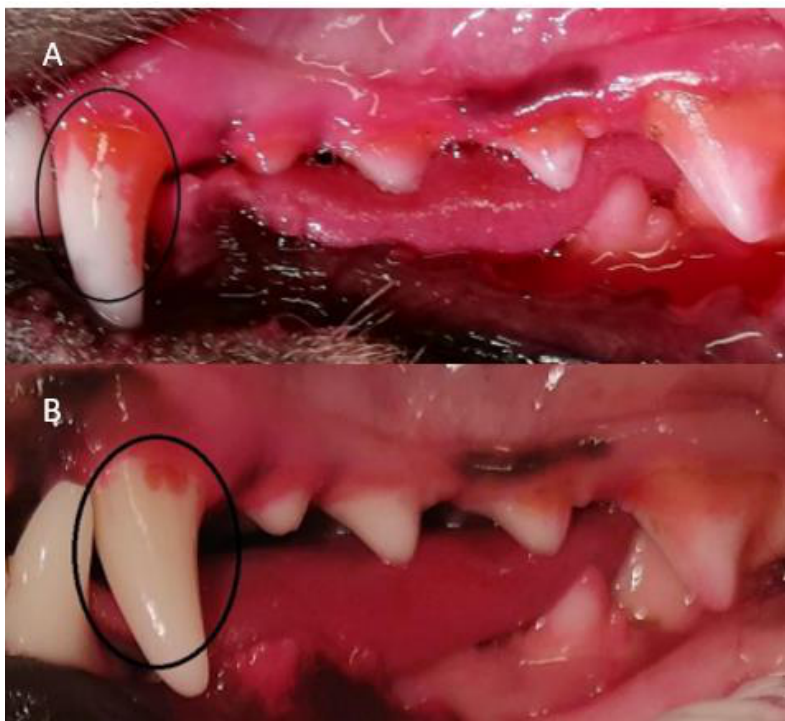
Figure 3. ( A ): Staining before treatment in dog ‘Toothbrush 6′. Red colour depicts plaque. (Photo: Fanny Eriksson) ( B ): Staining of the left side of dog ‘Toothbrush 6′ after dental cleaning with an ultrasonic toothbrush. The amount of plaque has decreased on tooth 204 at the final staining. Small remnants of plaque can still be seen on some teeth. (Photo: Sara Wiman).